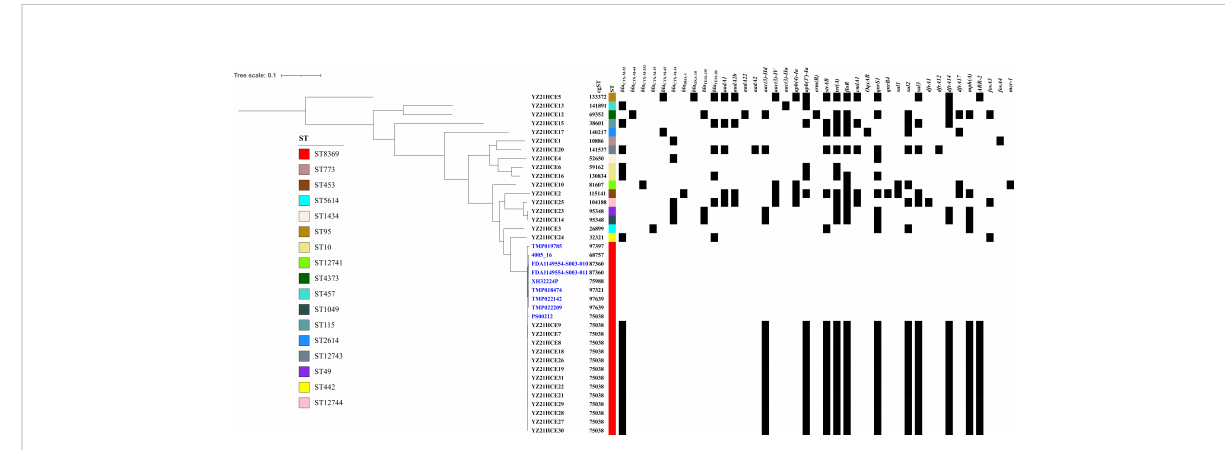
FIGURE 1 The maximum likelihood tree of cefotaxime-resistant E. coli isolates in this study compared with E. coli ST8369 isolates from EnteroBase (https://enterobase.warwick.ac.uk/) (in blue) based on cgSNP analysis. Antibiotic resistance genes with >90% sequence homology and coverage are